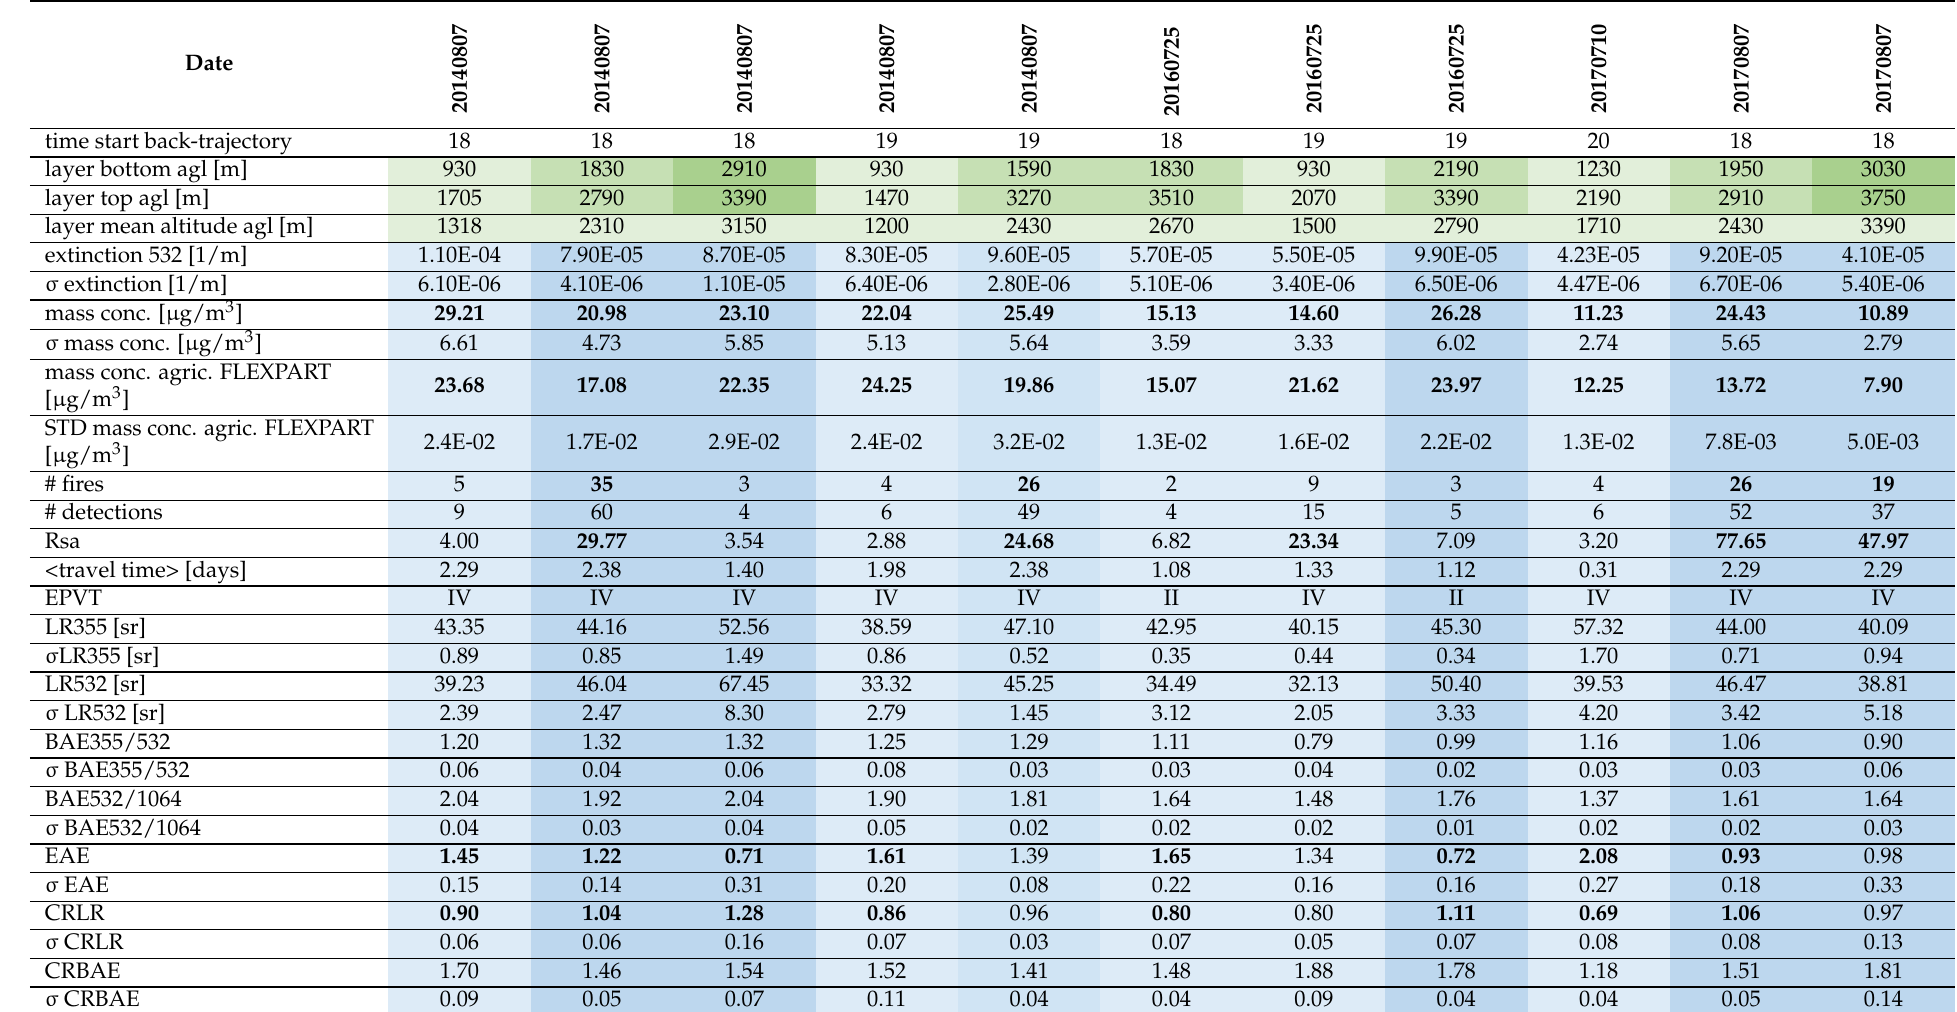
Table 6. The main features for the 11 smoke layers. The fresh smoke is highlighted in light blue and the aged smoke in darker